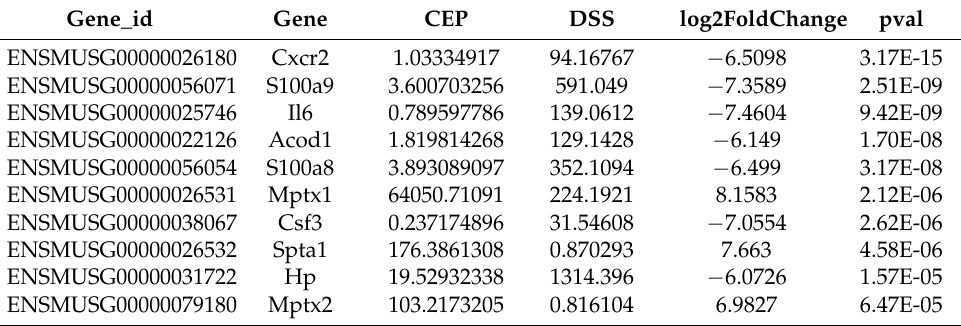
Figure 2. CEP inhibits LPS-induced secretion of pro-inflammatory cytokines and ACOD1 expression in RAW264.7 macrophages. ( A ) Concentrations of inflammatory factors (TNF- α , IL-1 β , and IL-6) in RAW264.7 cell culture medium were measured by ELISA after different concentrations of CEP and LPS administration for 24 h; ( B ) ACOD1 detection in macrophages by immunofluorescence microscopy; ( C ) ACOD1 detection in macrophages by Western blot (WB). * p < 0.05; ** p < 0.01; **** p < 0.001. Table 1. DEGs between the CEP-treated group and the DSS